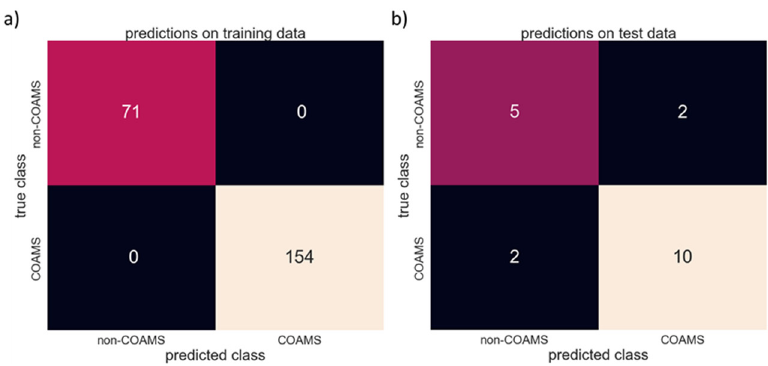
Figure 3. Model accuracy on the ( a ) training data and ( b ) test data.